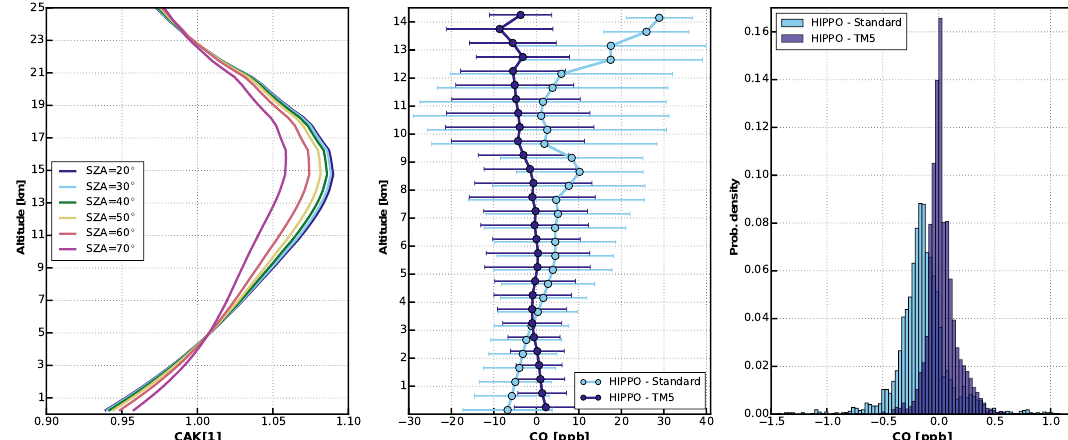
Figure 2. Left panel: SCIAMACHY CO total column averaging kernels for different solar zenith angles (SZAs). Middle panel: profile shape difference between HIPPO and TM5/US standard atmosphere. Right panel: probability density distribution of the null-space